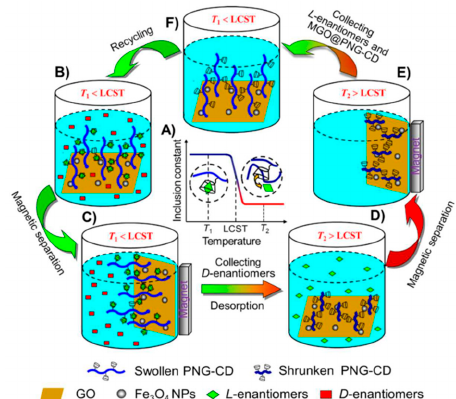
AAs enantiomers by MGO@PNG-CD. (A) As the temperature is below the LCST of PNIPAM chains (T1), the β -CD units in PNG-CD can selectively recognize and accommodate L -enantiomers to form stable host-guest inclusion complexes, while as the temperature is above the LCST of PNIPAM chains (T2), the loaded L -enantiomers can desorb from the β -CD cavities automatically because of the reduction in the inclusion constants of β -CD/ L -enantiomers complexes; (B) The MGO@PNG-CD is added in the AAs enantiomeric solution at T1 and the PNIPAM chains are swollen, and then L -enantiomers are recognized by β -CD; (C) Through an external magnetic field L -enantiomers are loaded on the MGO@PNG-CD, and D -enantiomers are remained in the enantiomeric solution for subsequent separation; (D) while the operating temperature is above the LCST of PNIPAM (T2), the PNIPAM chains occur to collapse, and the loaded L -enantiomers are released, and the MGO@PNG-CD is recycled; (E and F) the regenerated MGO@PNG-CD is recovered using a magnet and reused. The figure and the caption have been adapted with permission from [111], Copyright © 2018 American Chemical